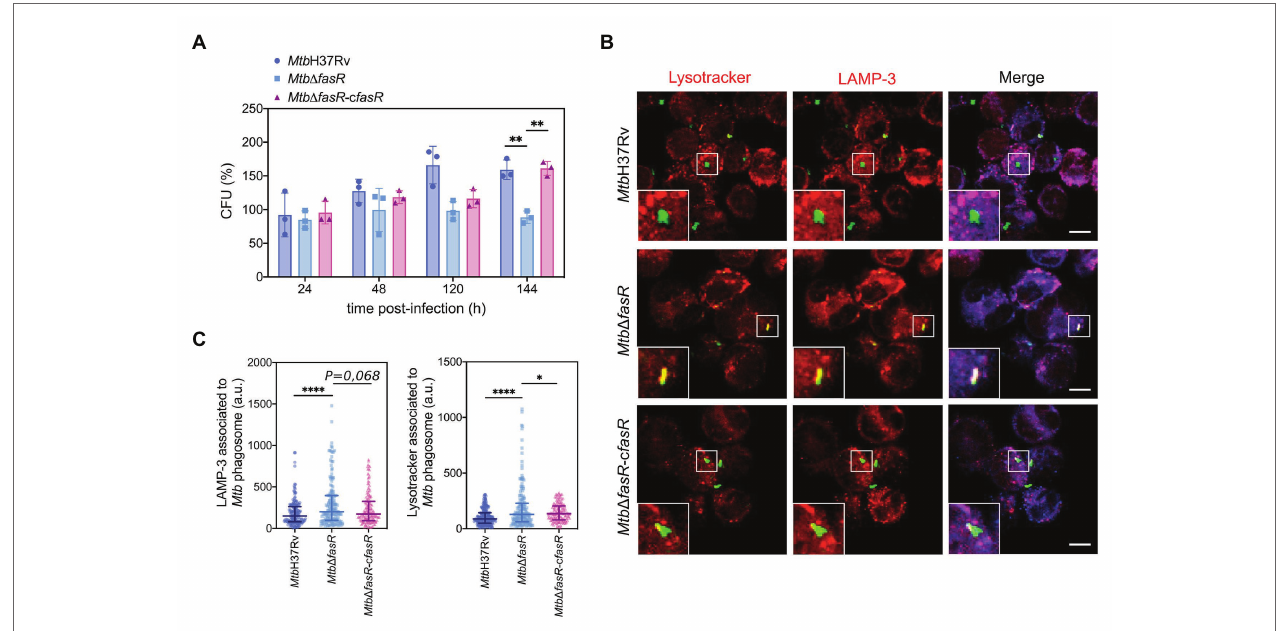
FIGURE 5 | FasR is required for the intracellular survival of M. tuberculosis . (A) THP-1-derived macrophages were infected with wild-type M. tuberculosis H37Rv ( Mtb H37Rv), fasR mutant ( Mtb Δ fasR ) and the complemented fasR strain ( Mtb Δ fasR -c fasR ). At different times post-infection (24, 48, 120, and 144 h) intracellular viable bacteria were counted. Bars represent means ± standard deviation of three independent experiments. Data were analyzed using two-way ANOVA with Tukey’s multiple comparisons test ( ** p ≤ 0.01). (B) Representative confocal images of THP-1 macrophages infected with the different FITC-labeled strains. Acidic compartments were stained with Lysotracker Red DND-99 and LAMP-3 was detected by indirect immunofluorescence using a specific antibody. Scale bars: 10 μ m. Merge indicates the location of the different strains in the phagolysosome. (C) Fluorescence intensity quantification of Lysotracker and LAMP-3 associated with the